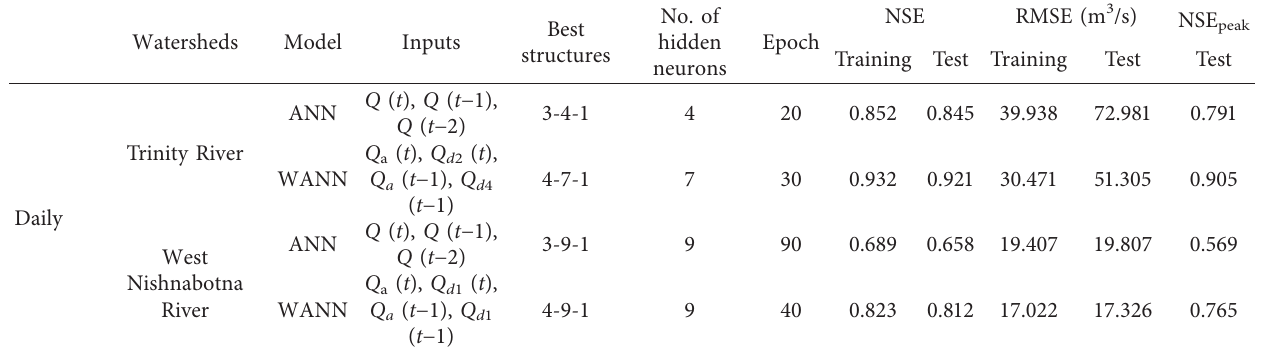
Table 6: Performance results of AI-based